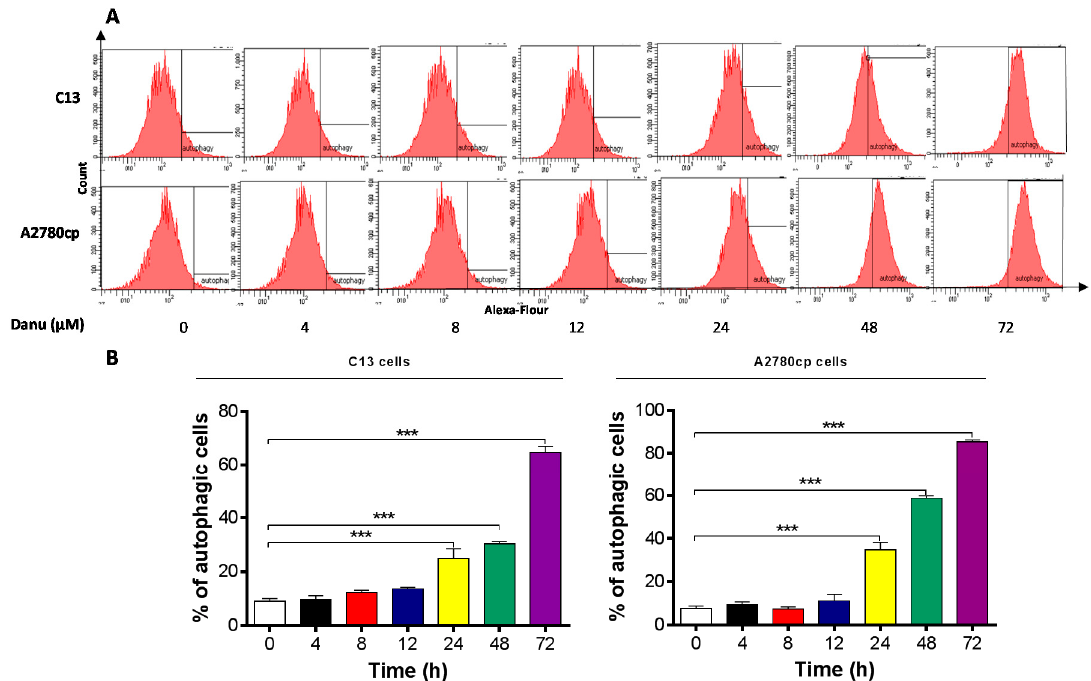
Figure 9. Danu induces autophagy in C13 and A2780cp cells over a 72-h treatment period determined by flow cytometry. C13 and A2780cp cells were incubated with Danu 0.5 µ M for 4, 8, 12, 24, 48, and 72 h and the samples were subject to flow cytometry. ( A ) Flow cytometric plots showing autophagy of C13 and A2780cp cells and ( B ) bar graphs showing the percentage of autophagic C13 and A2780cp cells. Data represent the mean ± SD of three independent experiments. *** p < 0.001 by one-way analysis of variance.